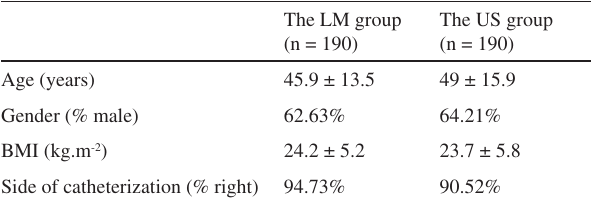
Table 1 - Characteristics of the